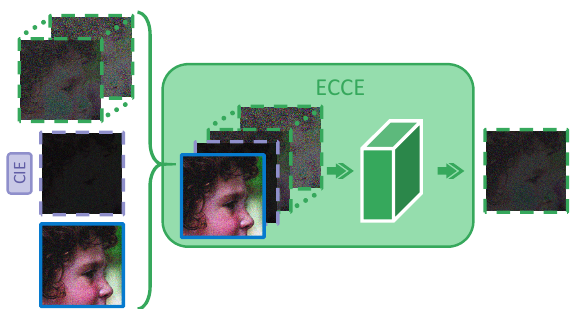
Figure 4. The pipeline of the ECCE module. In the iteration i , the module CIE i and its output CFEI i are both marked in purple. The CR i and the previous EEI s output by ECCEs are marked as blue solid wireframes and green dotted boxes, respectively. ECCE i takes CR i , CFEI i , and EEI ( 2 ∼ ( i − 1 )) as input and outputs EEI i . The green arrows represent the 3 × 3 convolution and activation options. I/O channels of the two convolution layers are i/32 and 32/1, respectively, for nonlinear mapping and comprehensive enhancement of EEI